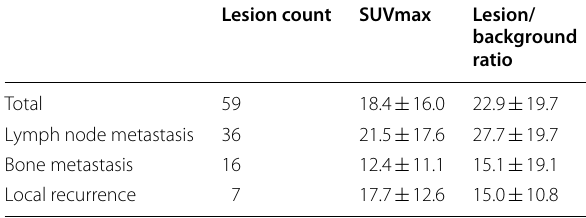
Table 3 Lesions detected in late-phase PET/CT Lesion count SUVmax Lesion/ background